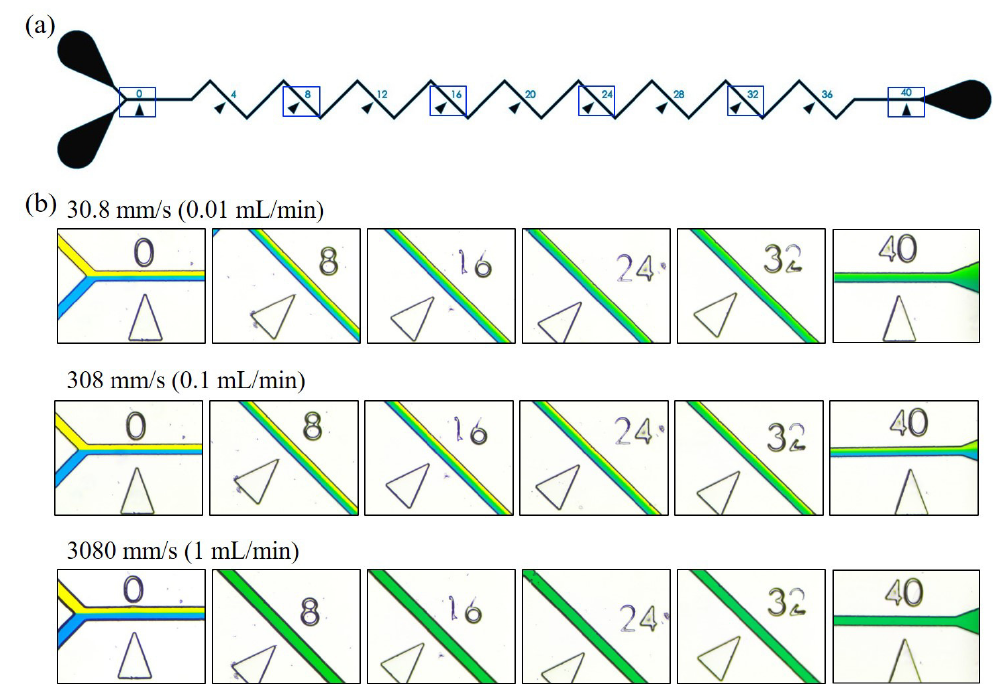
Figure 5. Experimental results of mixing performance at different locations in a zigzag channel. ( a ) The boxes on the channel show the locations of observation. ( b ) The experimental results of mixing at the locations under three different flow